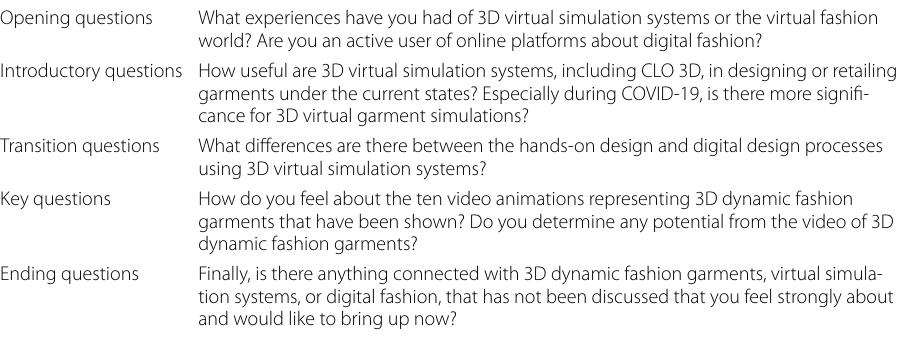
Table 3 Questions of the focus group